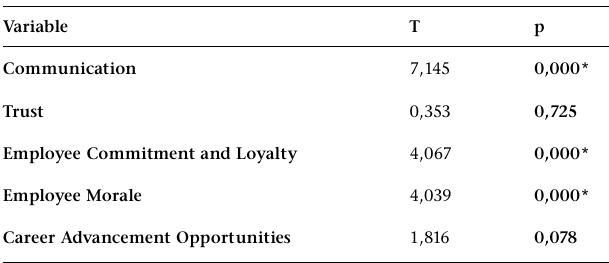
T-T EST : D IFFERENCES IN PERCEPTION BASED ON